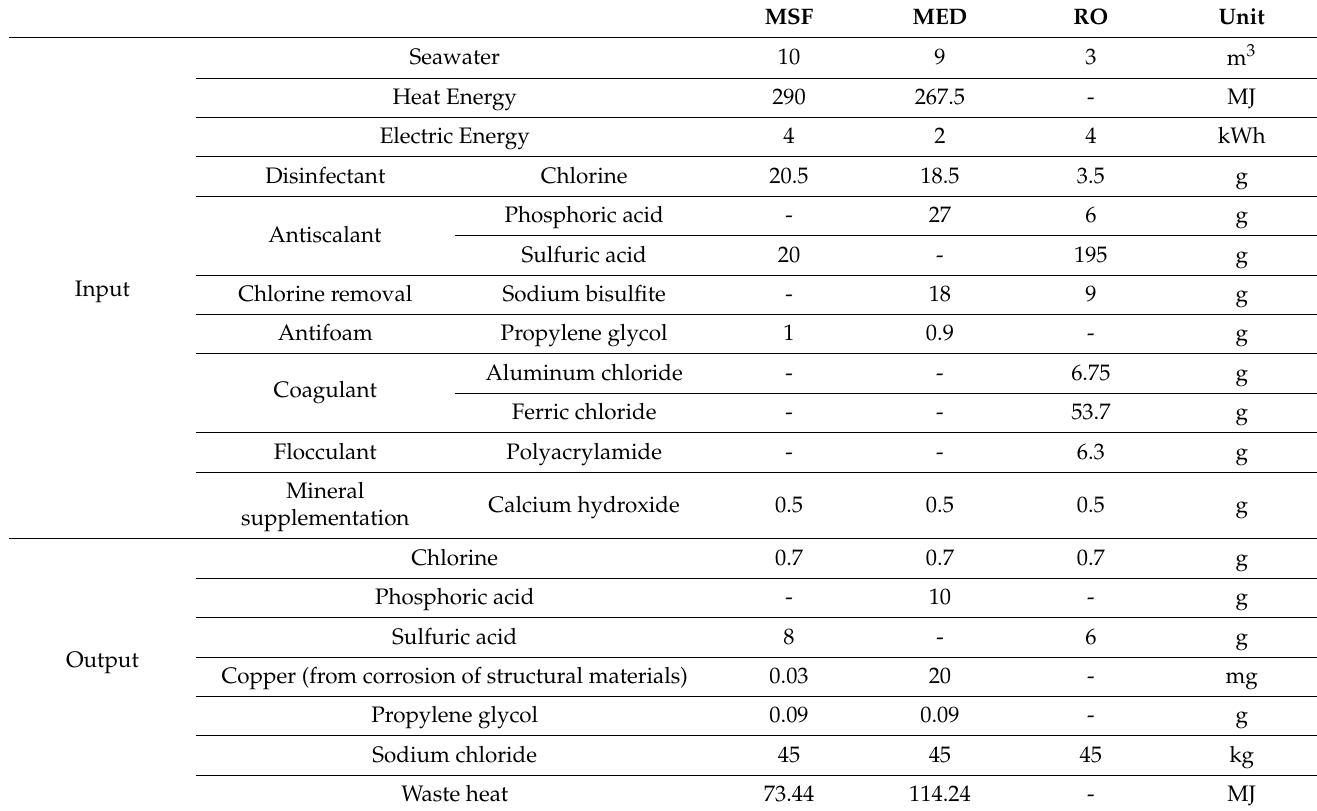
Table 5. Typical desalination plant inventory data for the production of 1 m 3 of drinking water [58].